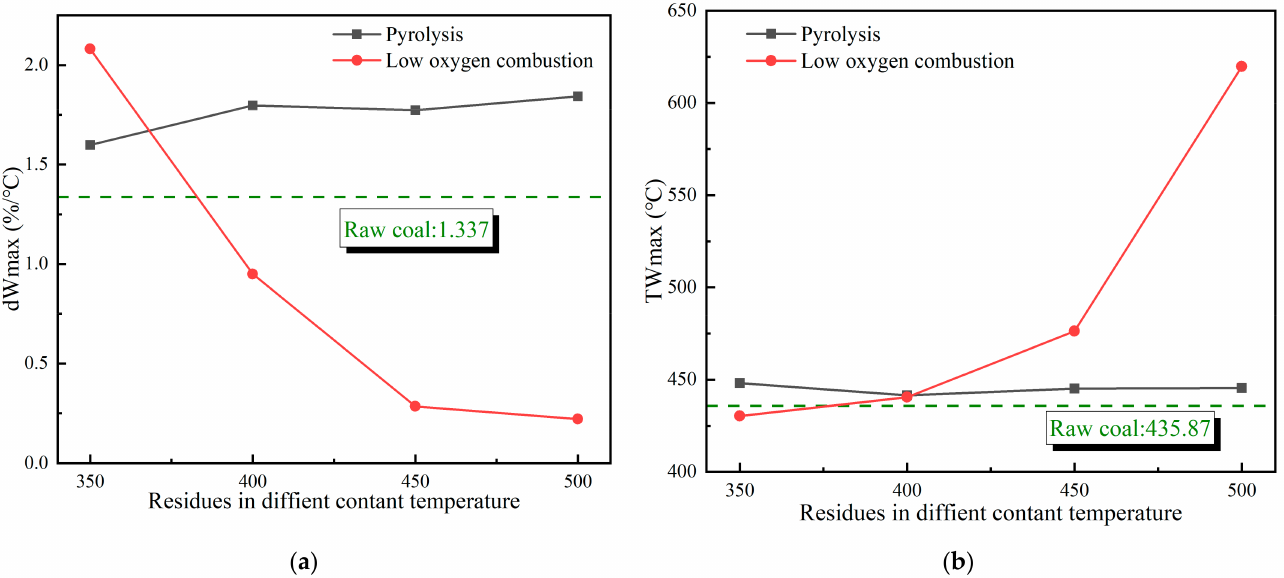
Figure 8. Variation curve of oxidation characteristic parameters of pyrolysis and low oxygen combustion residues. ( a ) The oxidation characteristic parameter is maximum speed of weightlessness, d Wmax . ( b ) The oxidation characteristic parameter is maximum weightlessness temperature, T Wmax